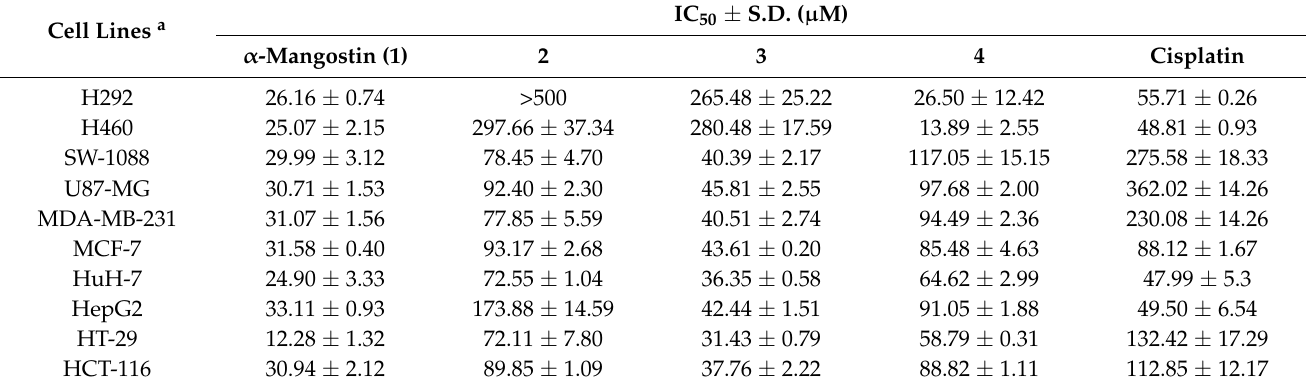
Table 2. Cytotoxicity of ( 1 ) and its analogs 2 – 4 against cancer cell